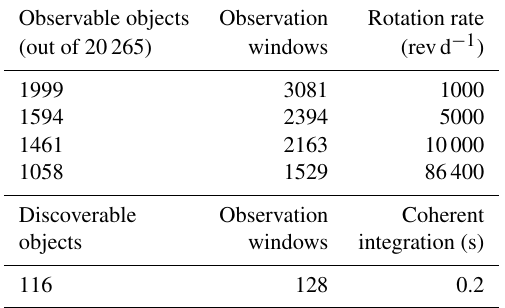
Table 2. Summary counts of the mini-moon observability simula- tions spanning 19 years and propagated for 10 years. The number of observable objects is representative of the expected total number of real mini-moons that can be tracked by E3D in future if prior orbital elements are known. Each object can have more than one possible observation window and, on average, each object has approximately 1.5 tracking opportunities. The number of discoverable objects in- dicates how many serendipitous mini-moon detections can be made if an E3D scan hits the object with an integration time of 0.2s. Only a few objects have multiple discovery opportunities.